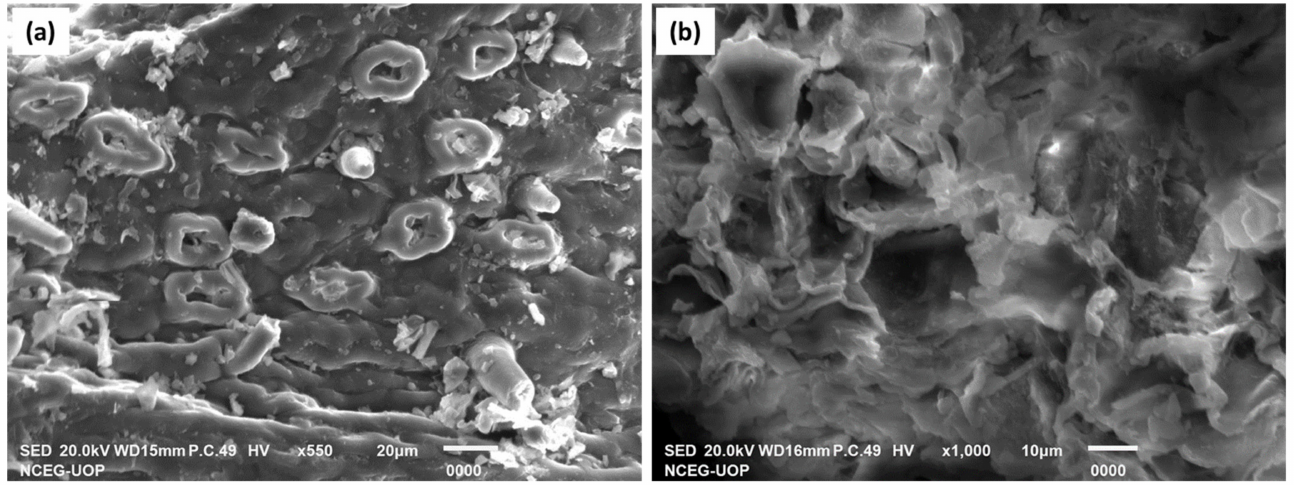
Figure 11. ( a ) SEM image of F. benghalensis leaves powder before adsorption. ( b ) SEM image of F. benghalensis leaves powder after adsorption of BG